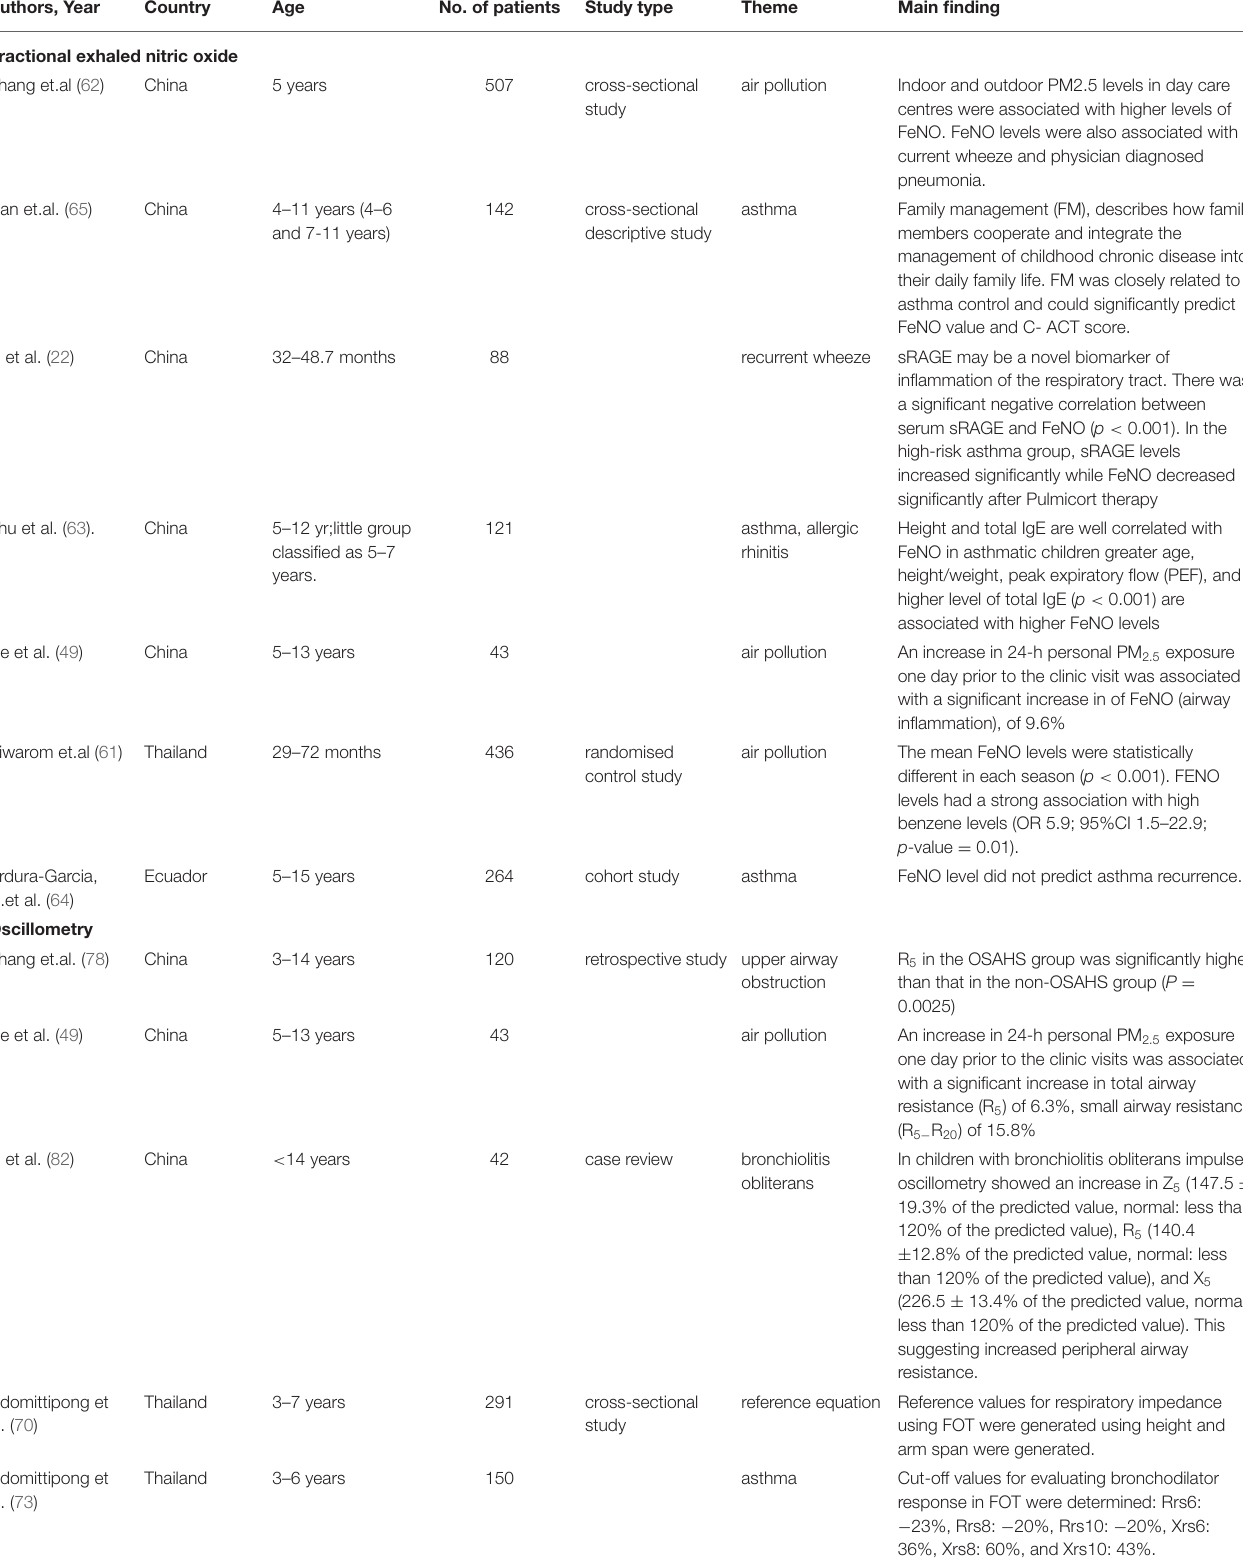
TABLE 2 | Detail of included studies that assessed fractional exhaled nitric oxide ( n = 7), oscillometry ( n = 15), interrupter technique ( n = 2). and tidal breathing ( n =